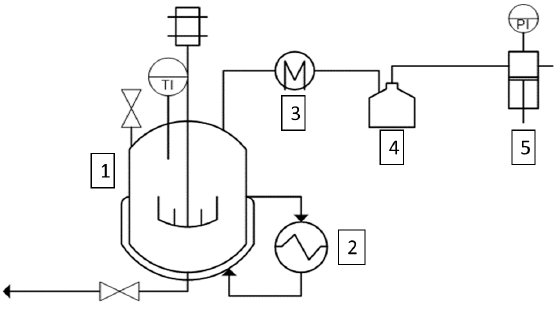
Figure 1. Sketch of reactor set-up of succinic-based (bS) polyol. 1: Reactor; 2: Heat exchanger device; Figure 1. Sketch of reactor set ‐ up of succinic ‐ based (bS) polyol. 1: Reactor; 2: Heat exchanger device; Figure 1. Sketch of reactor set ‐ up of succinic ‐ based (bS) polyol. 1: Reactor; 2: Heat exchanger device; Figure 1. Sketch of reactor set ‐ up of succinic ‐ based (bS) polyol. 1: Reactor; 2: Heat exchanger device;